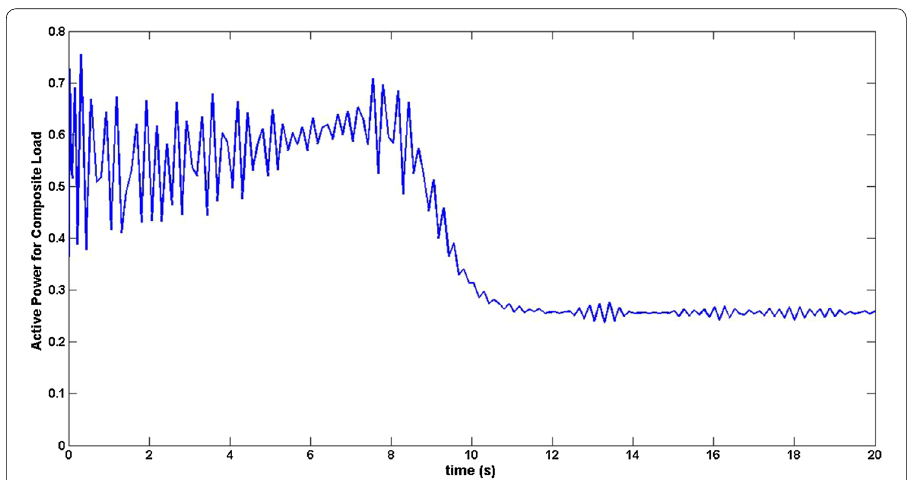
Fig. 10 The reactive power of DG source with increases in composite load of 1%